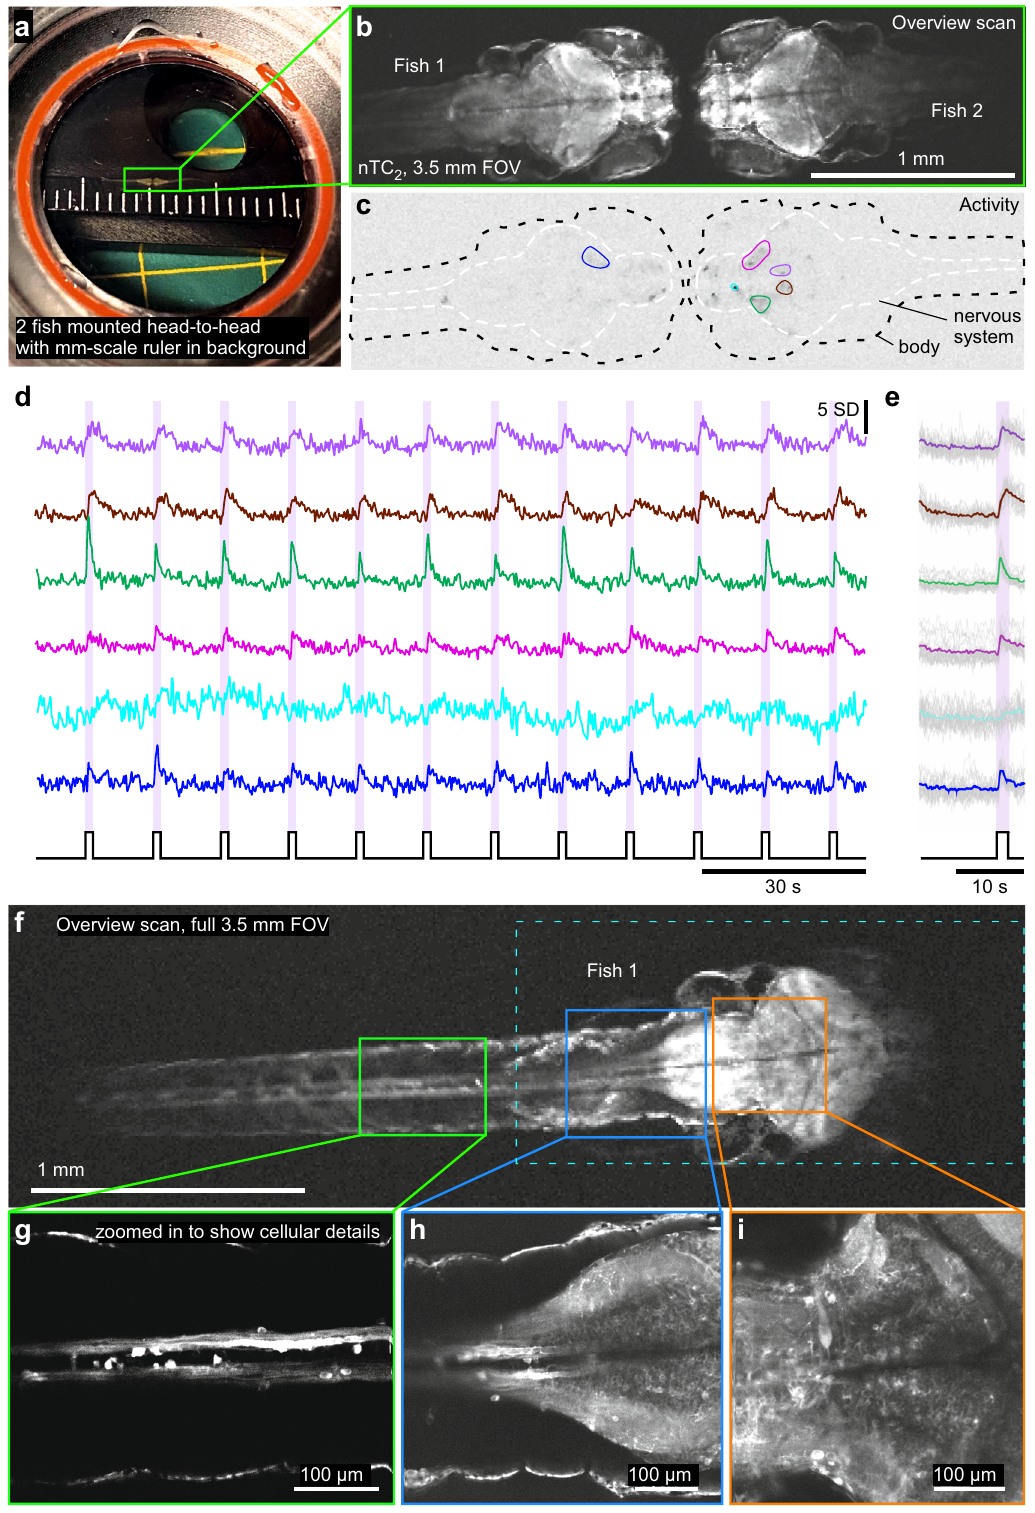
Fig. 5 Mesoscale imaging of zebra fi sh larvae. a Photograph of two 9 dpf zebra fi sh larvae mounted head-to-head in a microscope chamber with mm-scale ruler in background. b The same 2 fi sh (HuC:GCaMP6f) as in ( a ) imaged under 2-photon with nTC 2 3.5 mm FOV con fi guration, at 512 × 128 px (3.91 Hz). c , d Activity-correlation (cf. Fig. 3c) of the scan in ( b ) during presentation of full- fi eld fl ashes of ultraviolet (UV)-light, with hand-selected exemplary ROIs, extracted time-traces ( d ) and light-stimulus-aligned averages ( e ). f – i The same fi sh as shown on the left in ( b , fi sh 1), now shown at full 3.5 mm fi eld of view (f, 512 × 128 px, 3.91 Hz) and increased spatial resolution scans of regions as indicated to reveal cellular detail ( g – i , 1024 × 1024 px, 0.49 Hz). RGC, retinal ganglion